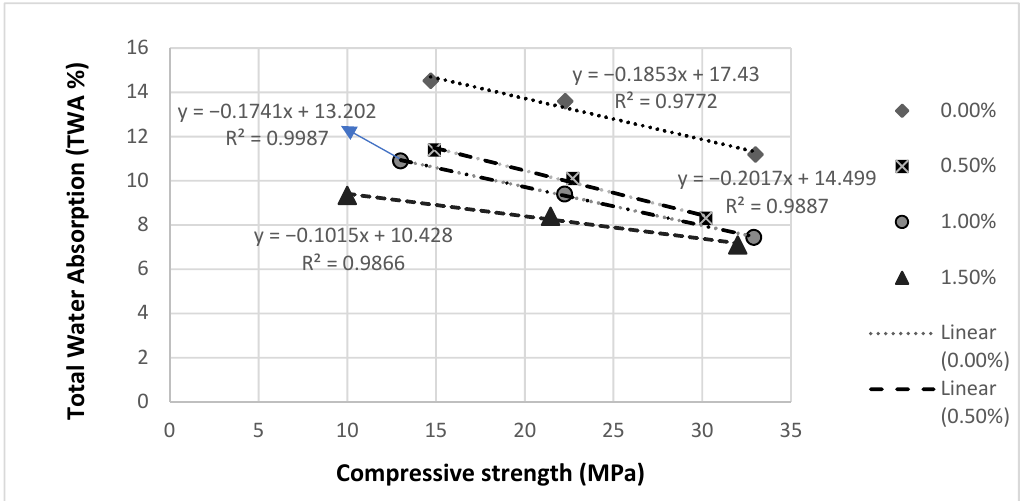
Figure 7. Correlation between compressive strength and total water absorption at different curing ages.